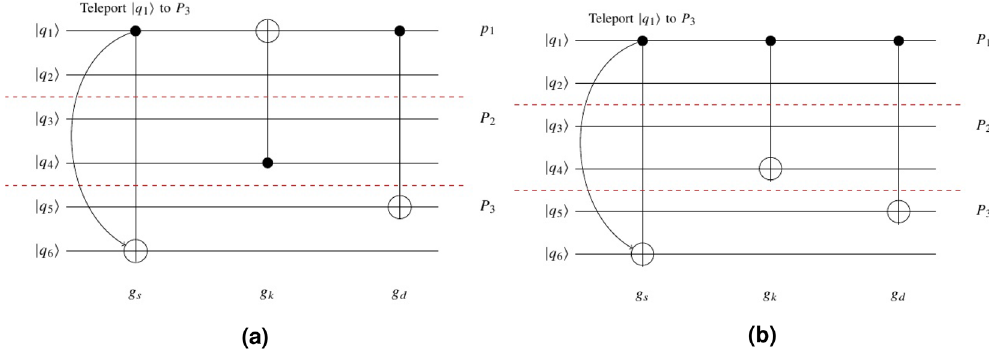
Figure 3. ( a ) By teleporting q 1 to P 3 , Gate g d cannot be executed. ( b ) By teleporting Qubit q 1 to P 3 , Gate g d can be